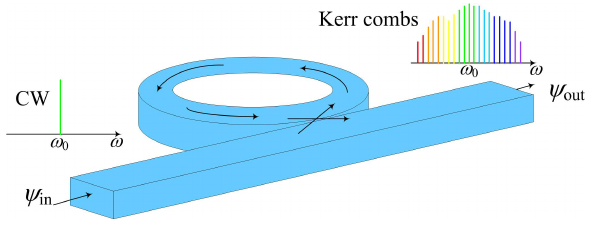
Figure 17: Schematic of Kerr comb formation in a micro-ring res-